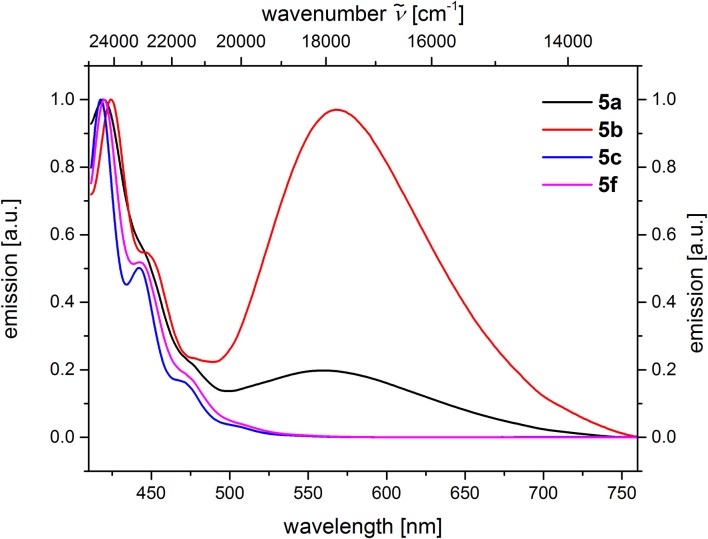
Comparison of emission spectra of compounds 5ac, f (recorded in CH2Cl2 (chromasolv), c(5) = 10−5
m, T = 298 K, λexc = 391 nm).